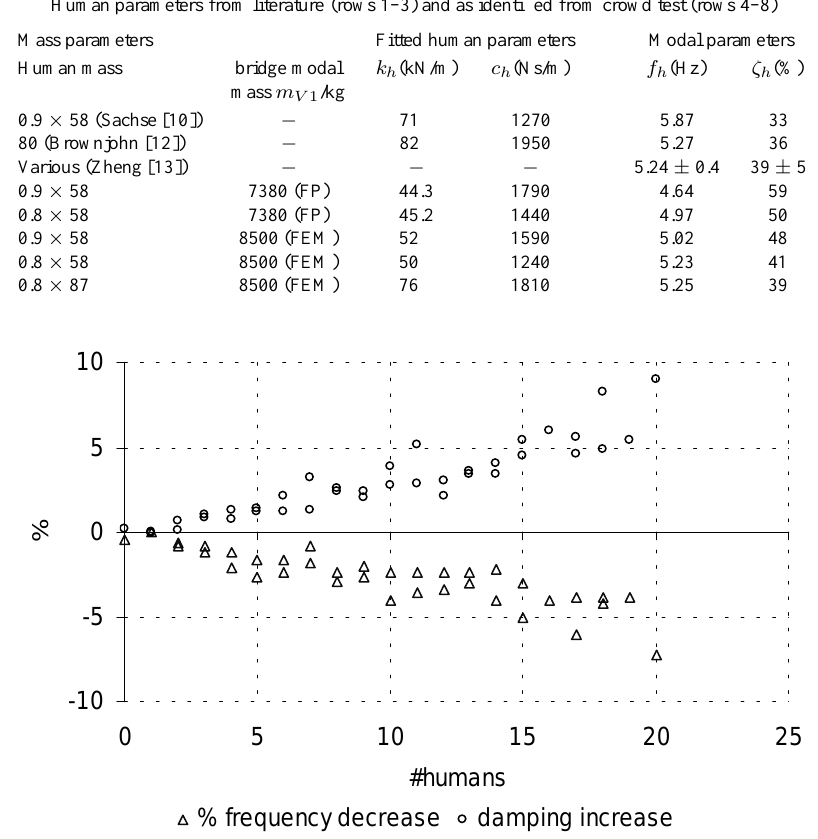
Table 3 Human parameters from literature (rows 1–3) and as identified from crowd test (rows 4–8)